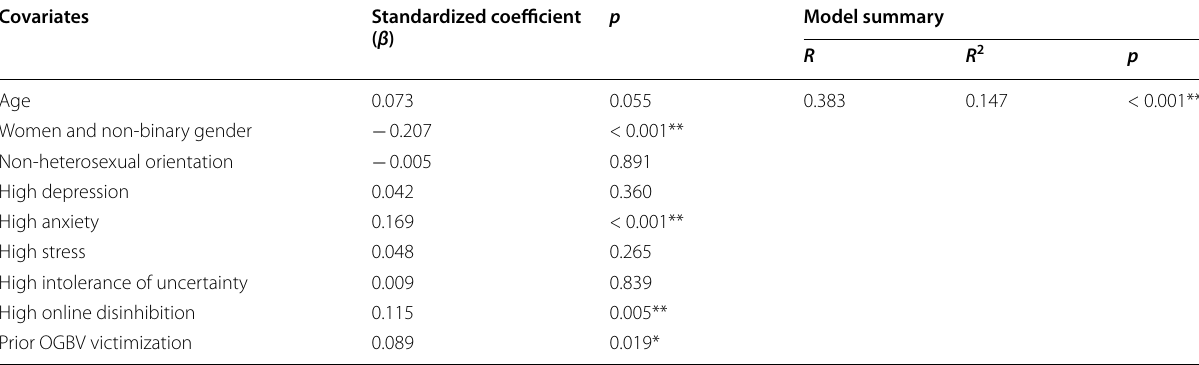
Table 4 Multivariate linear regression sub-group analysis for determinants of severity and frequency perpetrating OGBV among